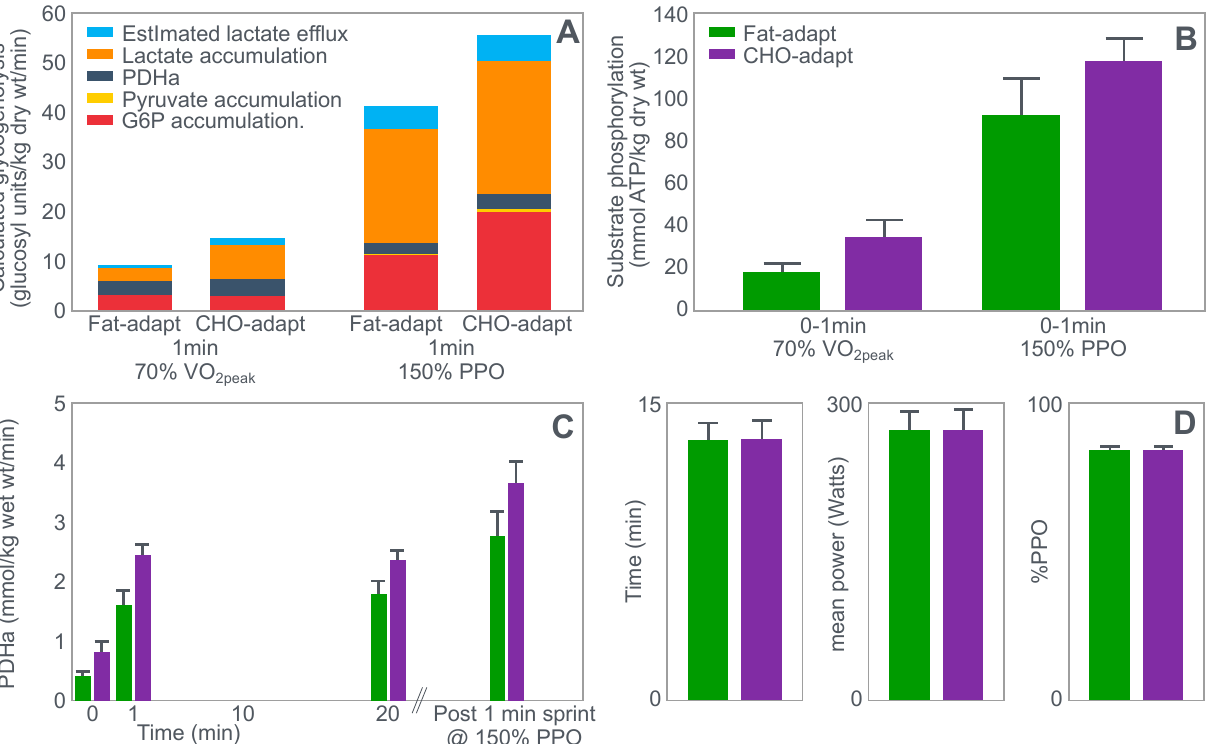
Figure 15. Changes in calculated glycogenolytic rates (panel A ), substrate phosphorylation (panel B ), and PDHa concentration (panel C ) during exercise at 70%VO2max and after a 1 min sprint at 150% peak power output (PPO) in subjects following short-term adaptation to high-carbohydrate or high-fat diets. Exercise performance during the self-paced time trial at ~90%VO2max—time to complete the time trial; mean power and % PPO was not influenced by the diet (panel D ). Adapted with permission from ref. [43]. Copy-right 2006 American Physiological Society.